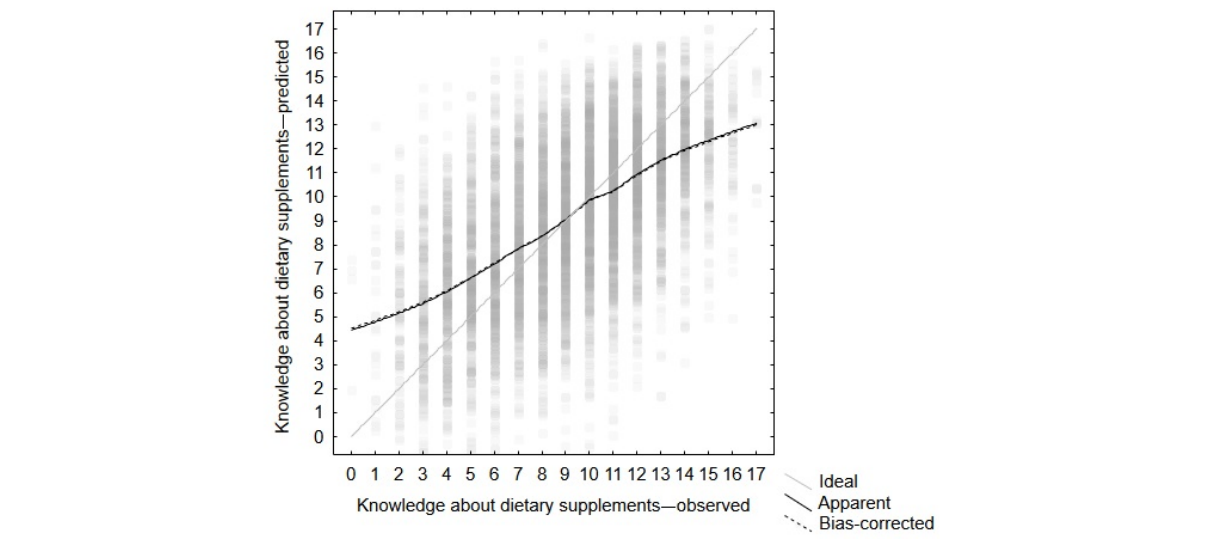
Figure 1. Calibration plot of the model to describe knowledge about dietary supplements. Black lines represent lowess (locally weighted scatterplot smoothing) fitted curves with a smoothing parameter of 0.25. The solid black line denotes the original (apparent) model, whereas the dotted black resulted from cross-validation (bias-corrected). The gray diagonal line represents hypothetical ideal prediction. Gray-filled circles depict individual data points predicted by the bias-corrected model. The circles are partially transparent; thus, the intensity of gray shadings reflects the density of points in an